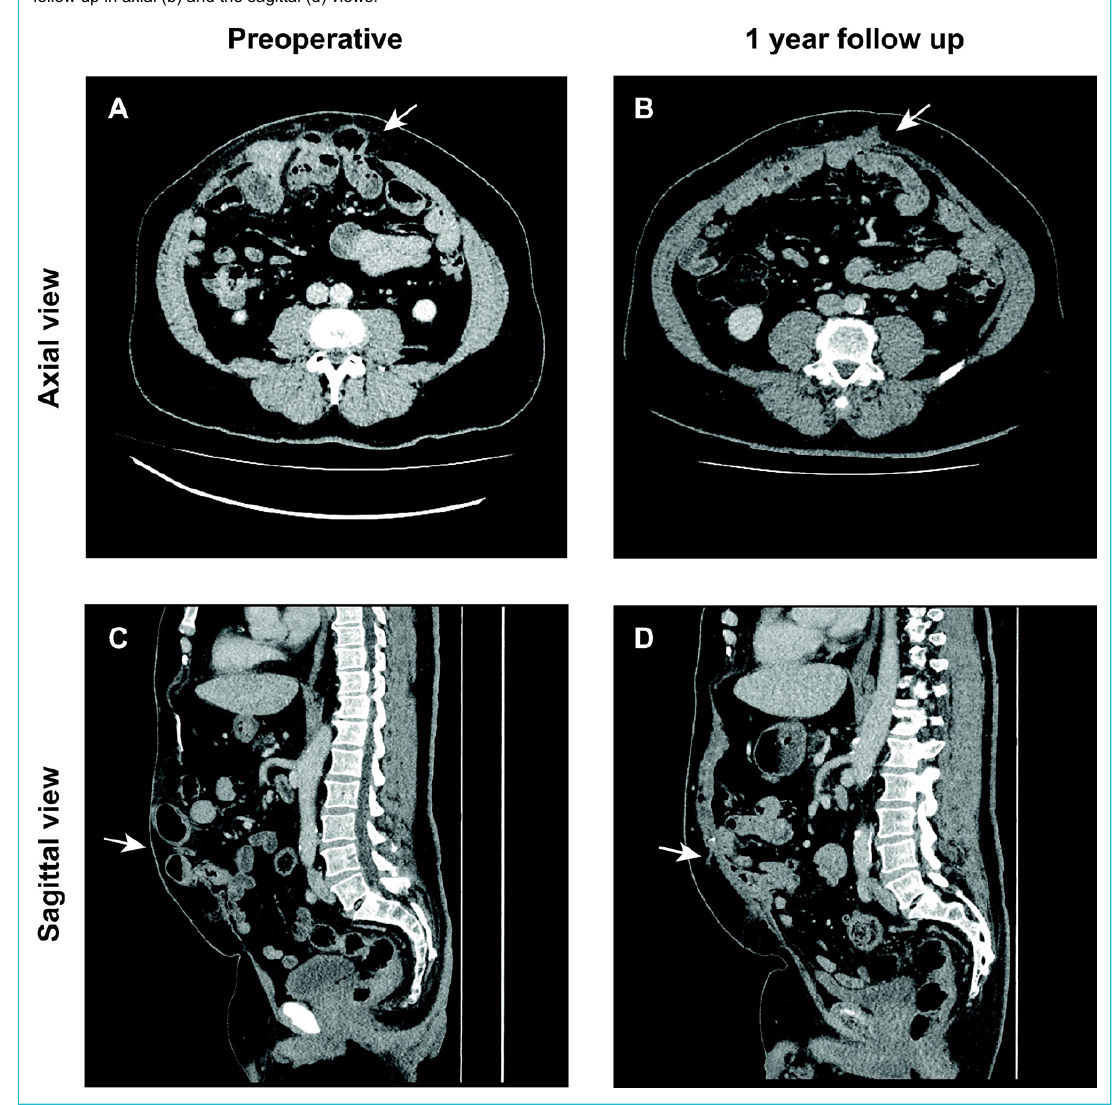
Figure 1: Abdominal computed tomography (CT) scan of the strangulated hernia in axial (a) and sagittal (c) views. Abdominal CT at 1-year follow up in axial (b) and the sagittal (d)